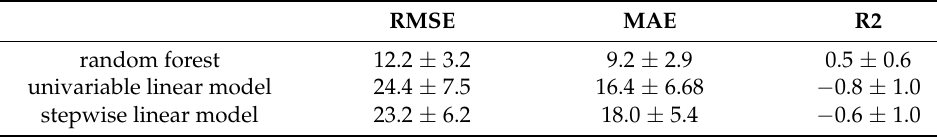
Table 3. Accuracy metric of the three predictive models on the test dataset.